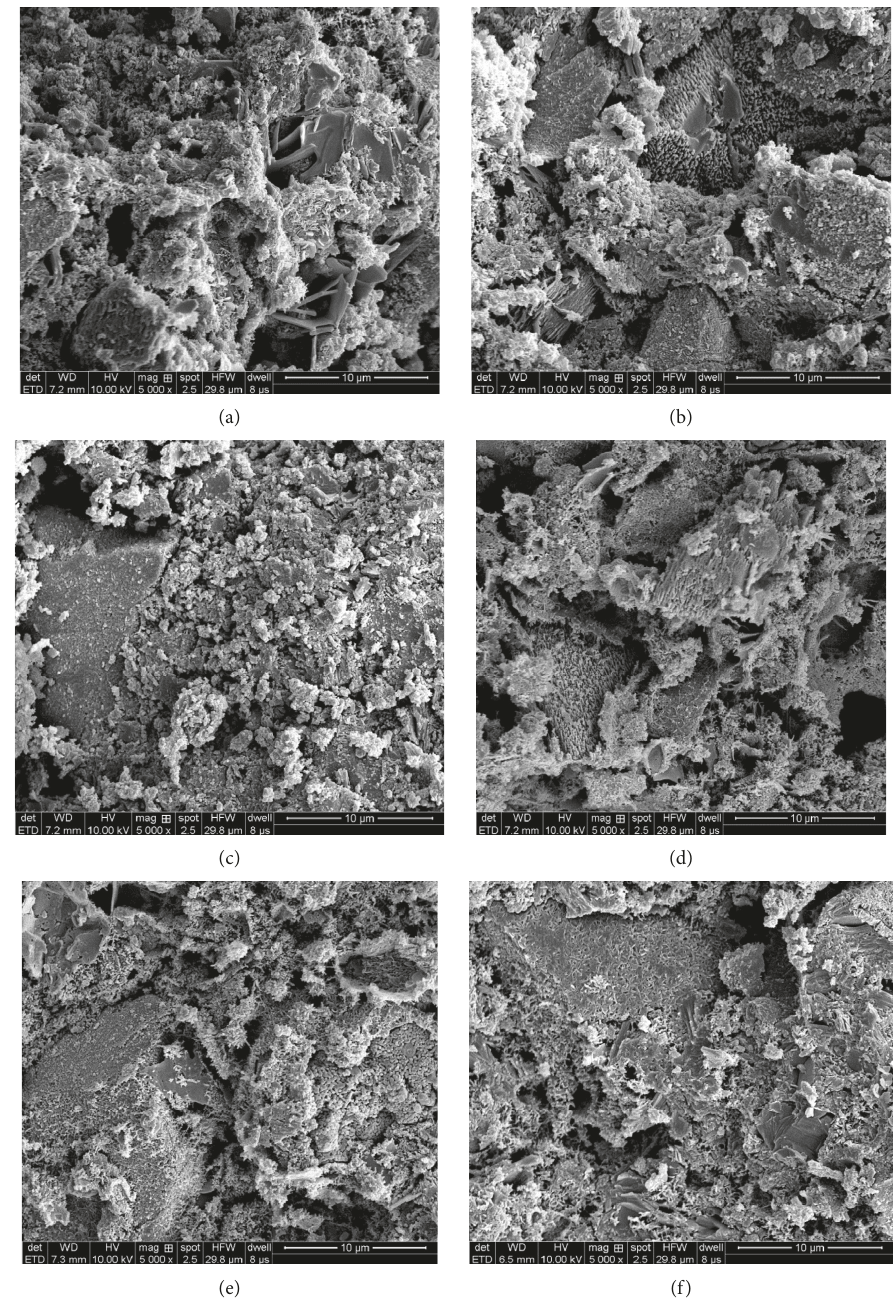
Figure 7: Microscopic images of C0 before and after exposure to different temperatures: (a) 20 ° C, (b) 200 ° C, (c) 400 ° C, (d) 600 ° C, (e) 800 ° C, and (f) 1000 °